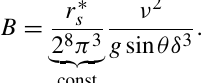
stable partly unstable stable ) | 0